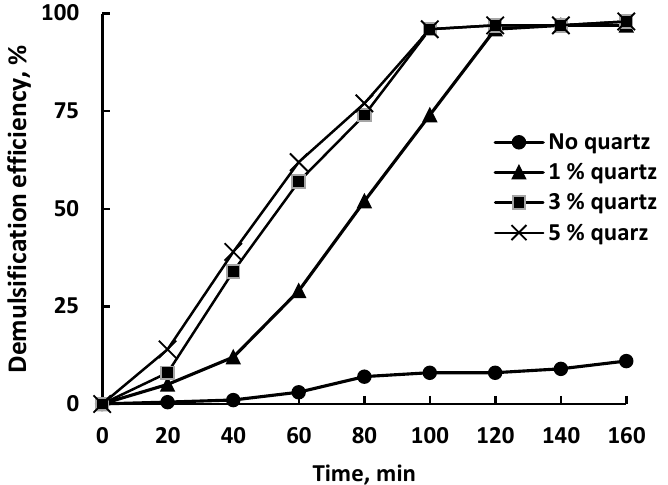
Figure 6. Demulsification efficiency of the FMQ particles with a mesh size of 75 μm.